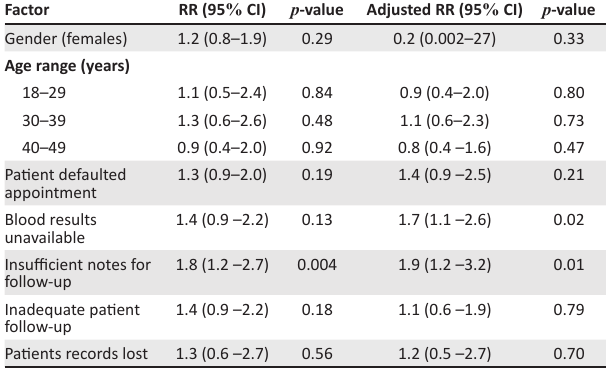
TABLE 1: Characteristics of patients switched to second-line antiretroviral treatment at an antiretroviral clinic in eThekwini Health District, 2011 to 2014. Patient characteristic